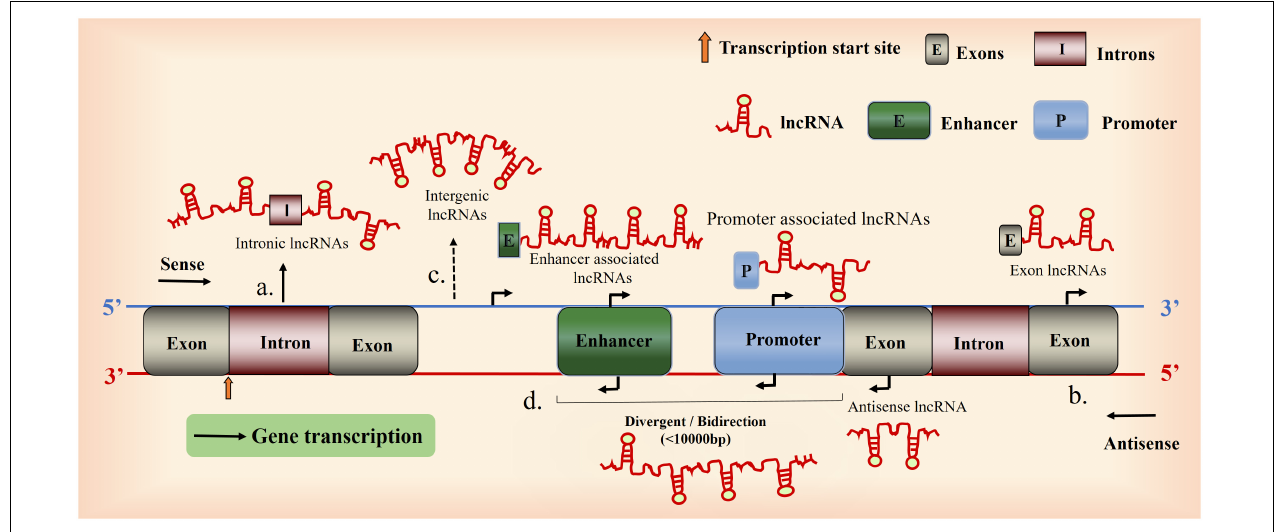
FIGURE 1 | Overview of long non-coding RNA (lncRNA) biogenesis. A Schematic diagram illustrating the origin of lncRNAs. (a), Intron sense or antisense lncRNAs. (b), Exon sense- or antisense lncRNAs. (c), between genes. (d), Bidirectional lncRNAs (the coding transcript is initiated in a genomic region of less than 1,000